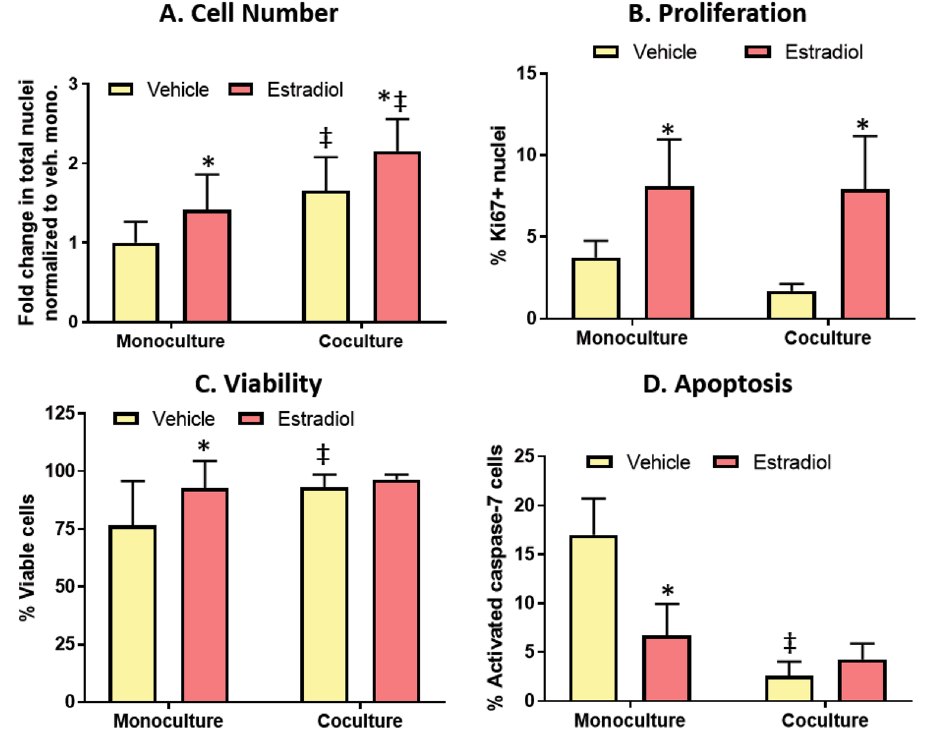
Figure 5. Fibroblasts increase cell number by increasing viability and reducing apoptosis. Cultures were dosed with a vehicle control or 100 nM E2 for 72 hours. ( A ) Total number of nuclei was measured to evaluate cell number. ( B ) Proliferation was measured by the percentage of cells positive for proliferation marker Ki67. ( C ) A live/dead assay was used to evaluate cell viability, where the cells were stained with calcein, Hoescht, and ethidium homodimer. ( D ) Cell apoptosis was measured by quantifying the number of nuclei positive for activated caspase-7, which is a key protein in the apoptosis cascade. A two-way ANOVA was run to evaluate interactions between conditions, followed by a Tukey’s multiple comparisons test to identify significant differences. * = vs. respective vehicle (p < 0.05) and ‡ = vs. respective monoculture (p < 0.05). Graphs represent data from three independent